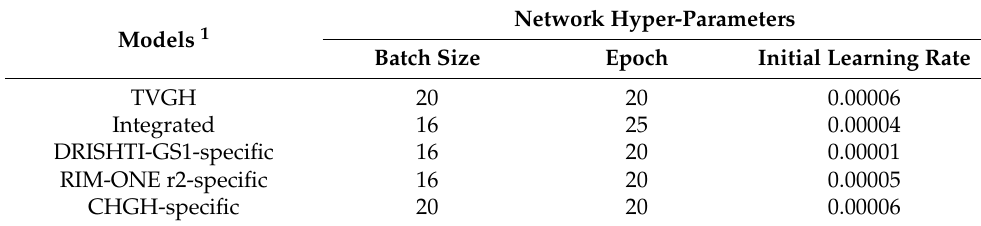
Table 2. Network hyper-parameters used in different Models.